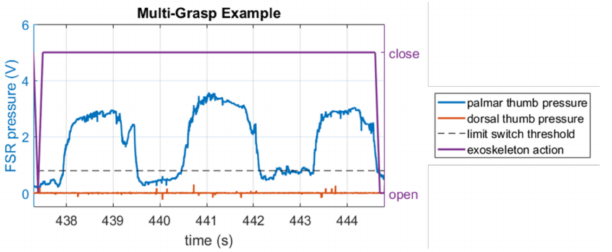
Figure 3. Example of a “multi-grasp” where the palmar thumb pressure crosses the limit switch threshold from below multiple times within a single exoskeleton close action, with below-threshold periods longer than 0.1 s interspersed.